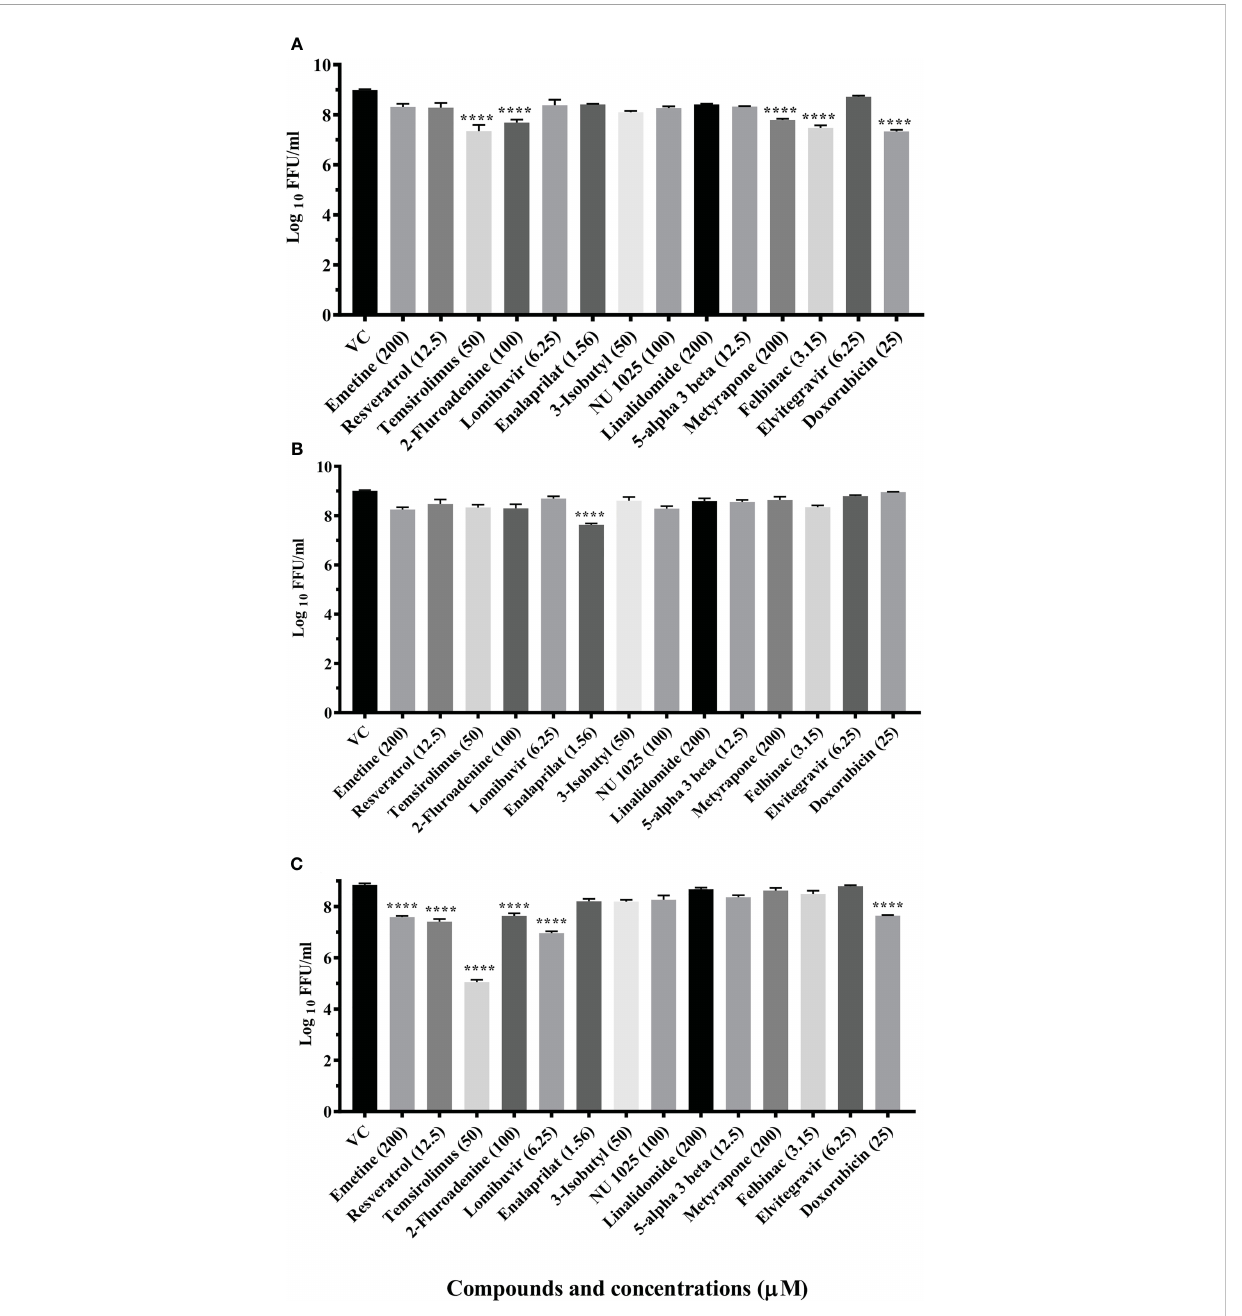
FIGURE 1 Primary screening of repurposed drugs at highest nontoxic concentration against CHIKV pretreatment (A) , cotreatment (B) and posttreatment (C) conditions. Vero CCL-81 cells treated with drugs under pre, co and posttreatment conditions at the highest maximum nontoxic dose and incubated for 24 (h) Plates were frozen after incubation, and culture fi ltrates were utilized for the FFU assay. The trials were carried out in triplicate at two different time points, and the outcomes were expressed as mean log 10 focus-forming unit/ml ± standard error. All the treatment conditions were compared with the VC. ****p <